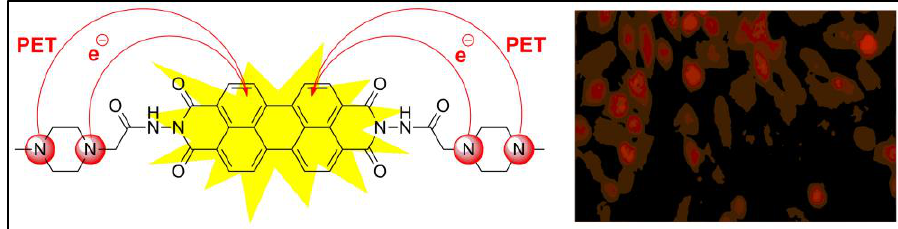
Figure 24. Perylene-3,4,9,10-tetracarboxylic diimide-based probe 23 . Adapted with permission from [97]. Copyright (2019) Elsevier.